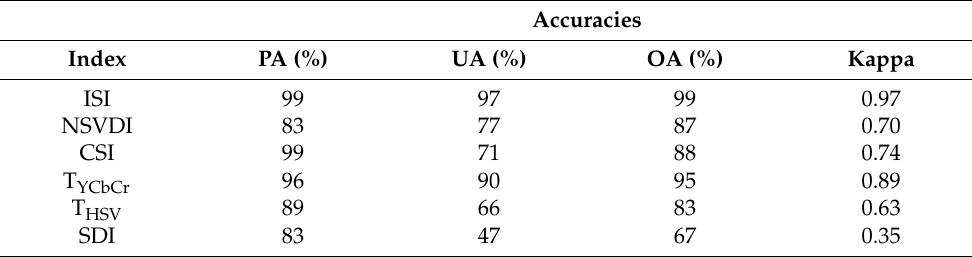
Table 3. Shadow extraction accuracy of the indexes in Site